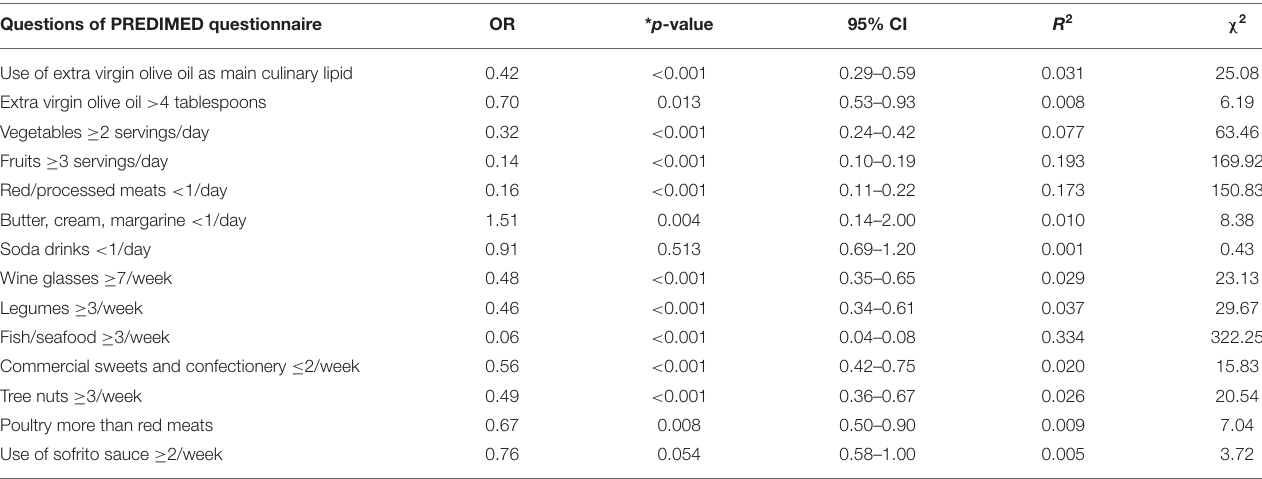
TABLE 8 | The bivariate proportional OR model performed to assess the association between the thyroid nodule presence/absence and the responses of each item included in PREDIMED questionnaire. Questions of PREDIMED